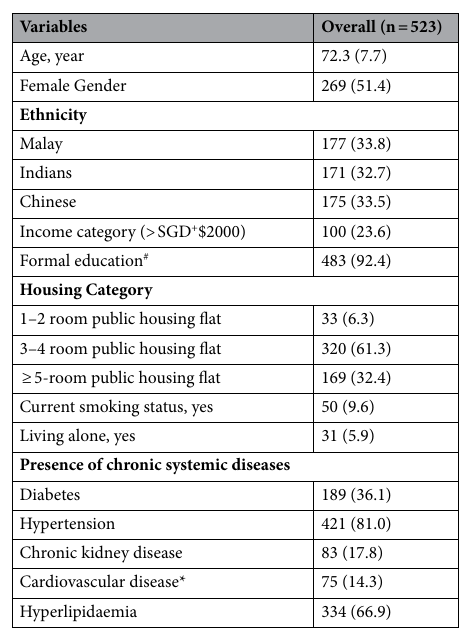
Table 1. Characteristics of included participants. Data presented are mean (standard deviation) or frequency (percentage), where appropriate. + SGD = Singapore Dollar. # Defined as having primary or higher education. *Defined based on self-reported history of stroke, heart attack or